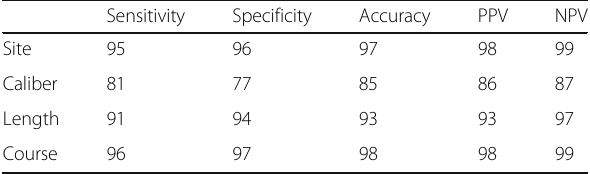
Table 1 Summarized the accuracy of P-CTA in the detection of the different parameters of each perforator; site in relation to the umbilicus, caliber of perforator as it pierces the rectus abdominis, and length and course of the intramuscular segment of the perforator ( p <